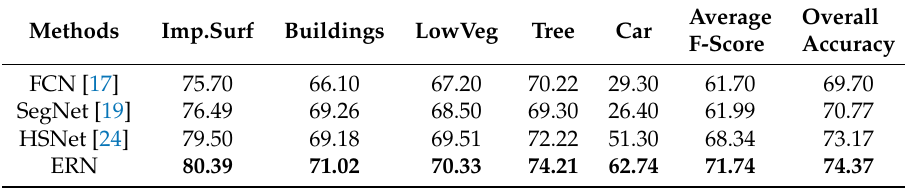
Table 6. Experimental results on the shadow-affected regions in the ISPRS Vaihingen Dataset. Imp.Surf: impervious surface; LowVeg: low